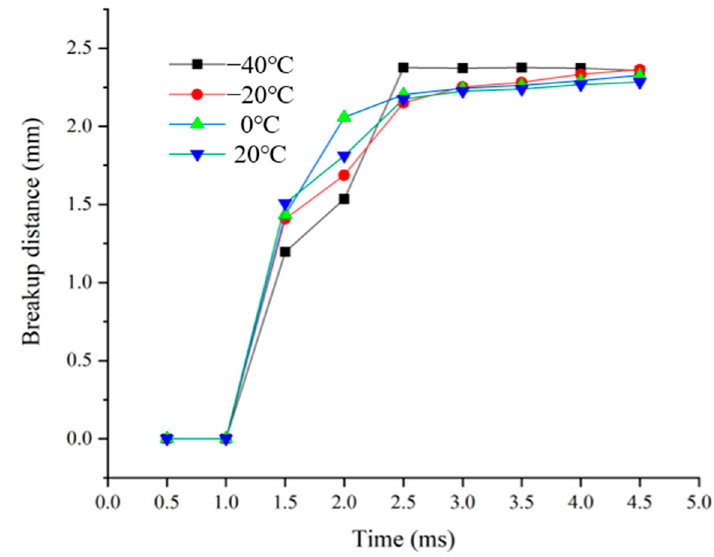
Figure 11. Comparison of the breakup distances at different temperatures over